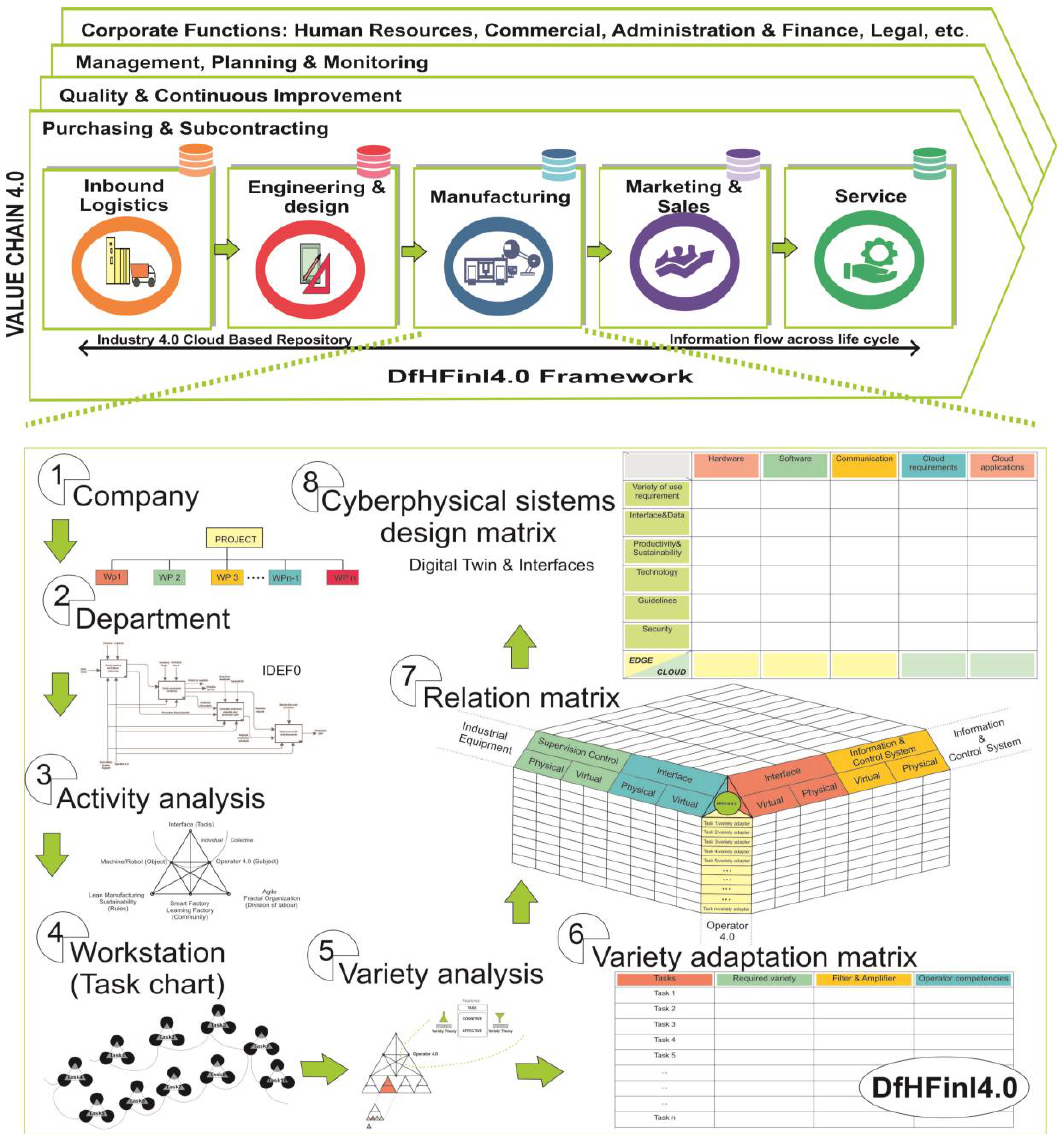
Figure 7. DfHFinI4.0 for the configuration of the integrated cyber-physical and co-evolutionary system.